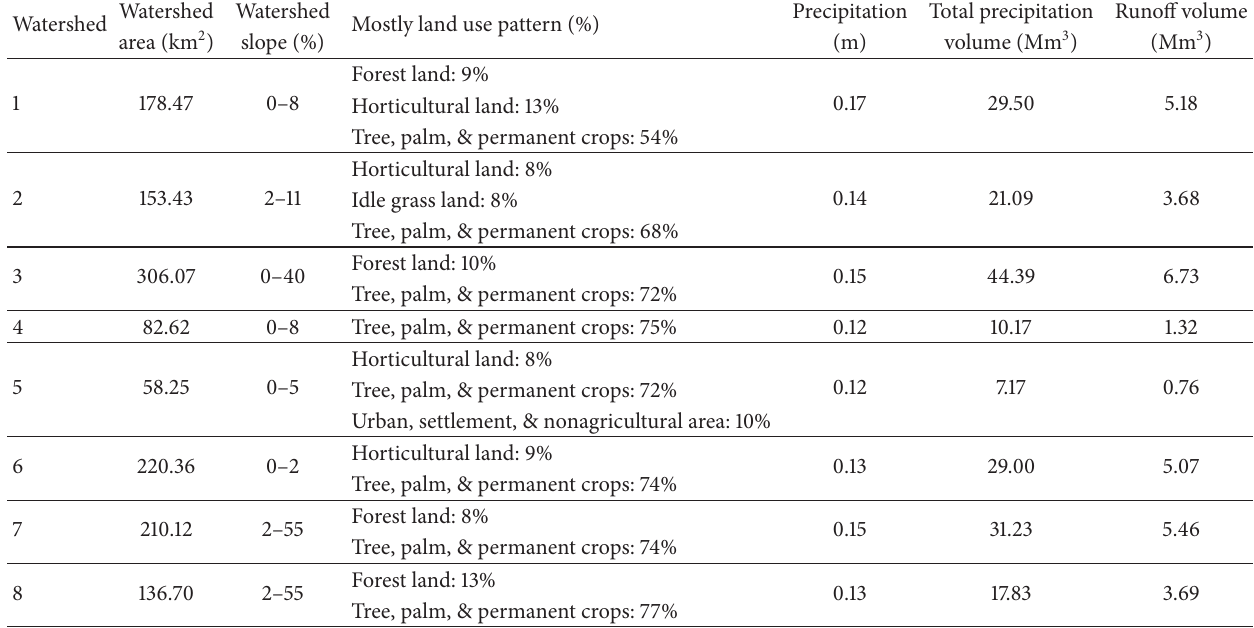
Table 5: Monthly precipitation and runoff volume of each